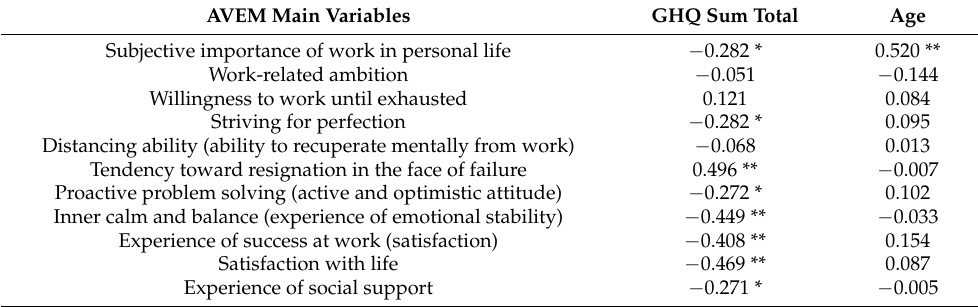
Table 4. Correlations (Spearman’s rho) between AVEM main variables, GHQ-12 sum total, and